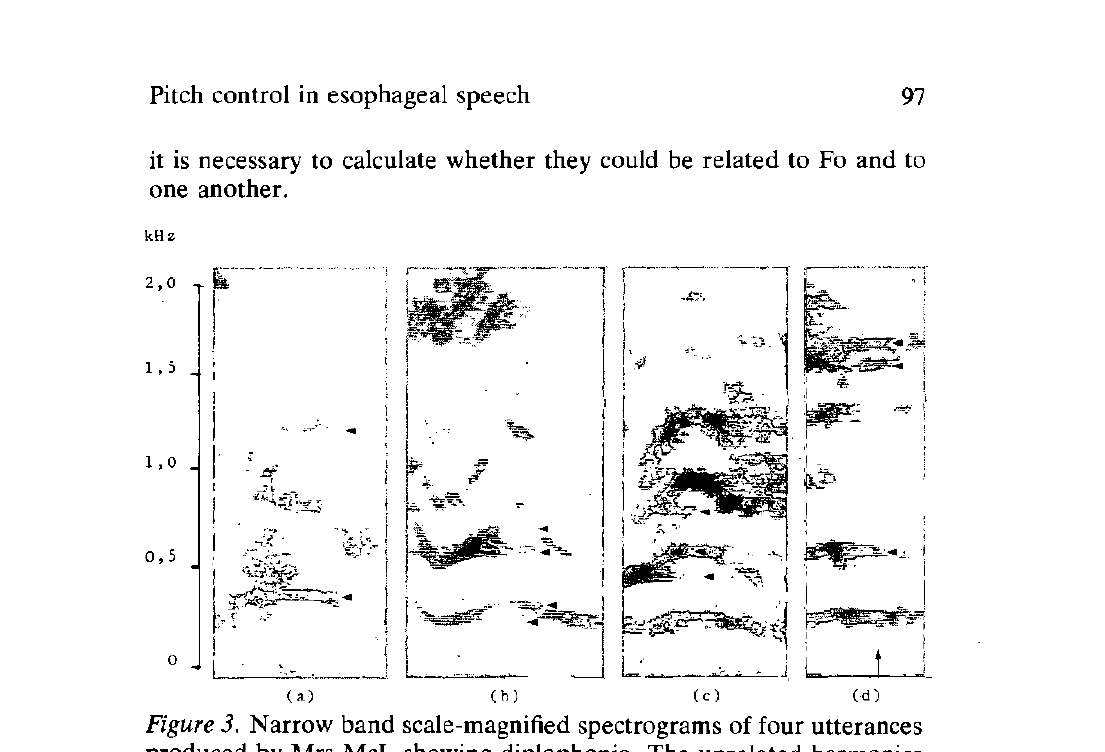
Figure 3. Narrow band scale-magnified spectrograms of four utterances produced by Mrs McL showing diplophonia. The unrelated harmonics are marked with